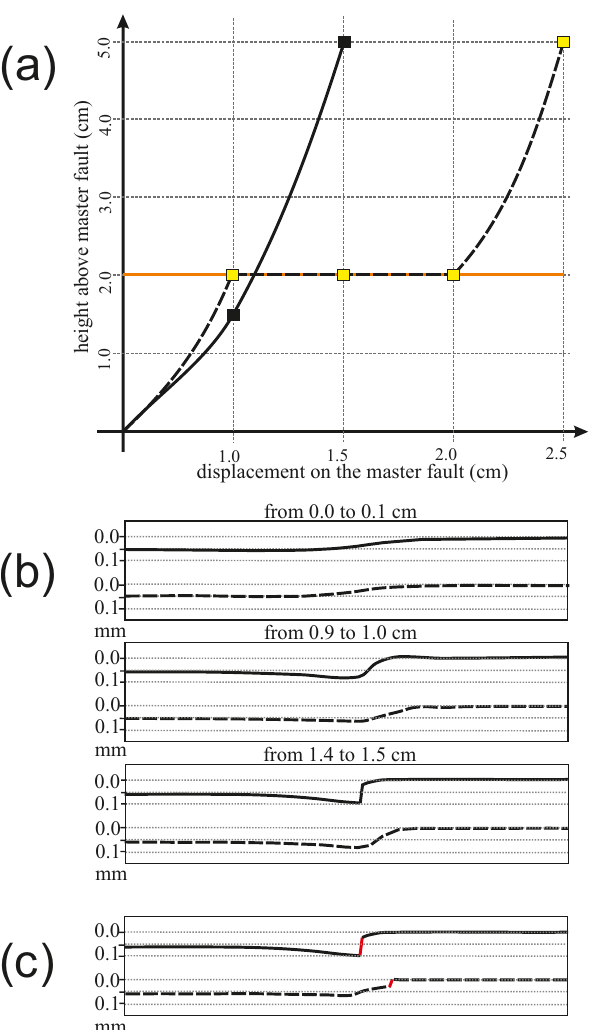
Figure 9. (a) Diagram showing the vertical location of the upper tip of the upward-propagating faults against the amount of displace- ment on the master fault. Thick black and dashed lines represent re- sults from WK1 and WK2, respectively. Orange lines represent the location of the pre-existing discontinuity in WK2. (b) Topography profiles of the WK1 (thick black lines) and WK2 (dashed lines) ex- periments at different intervals. (c) Final topographic profile of the wet clay experiments, showing the location of the surface-breaking faults (red lines). Data in diagrams (b) and (c) come from the DIC analyses shown in Figs. 7 and 8 (right